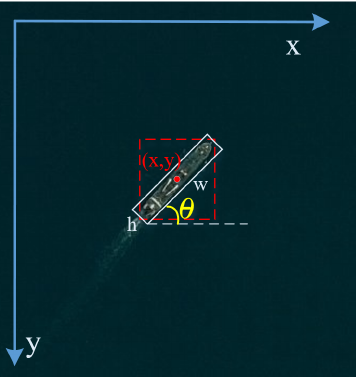
Figure 7. The illustration for the rotation angle. Red line of dashes represents the HBB; White line represents the OBB. θ represents the rotated angle between the x-axis and w